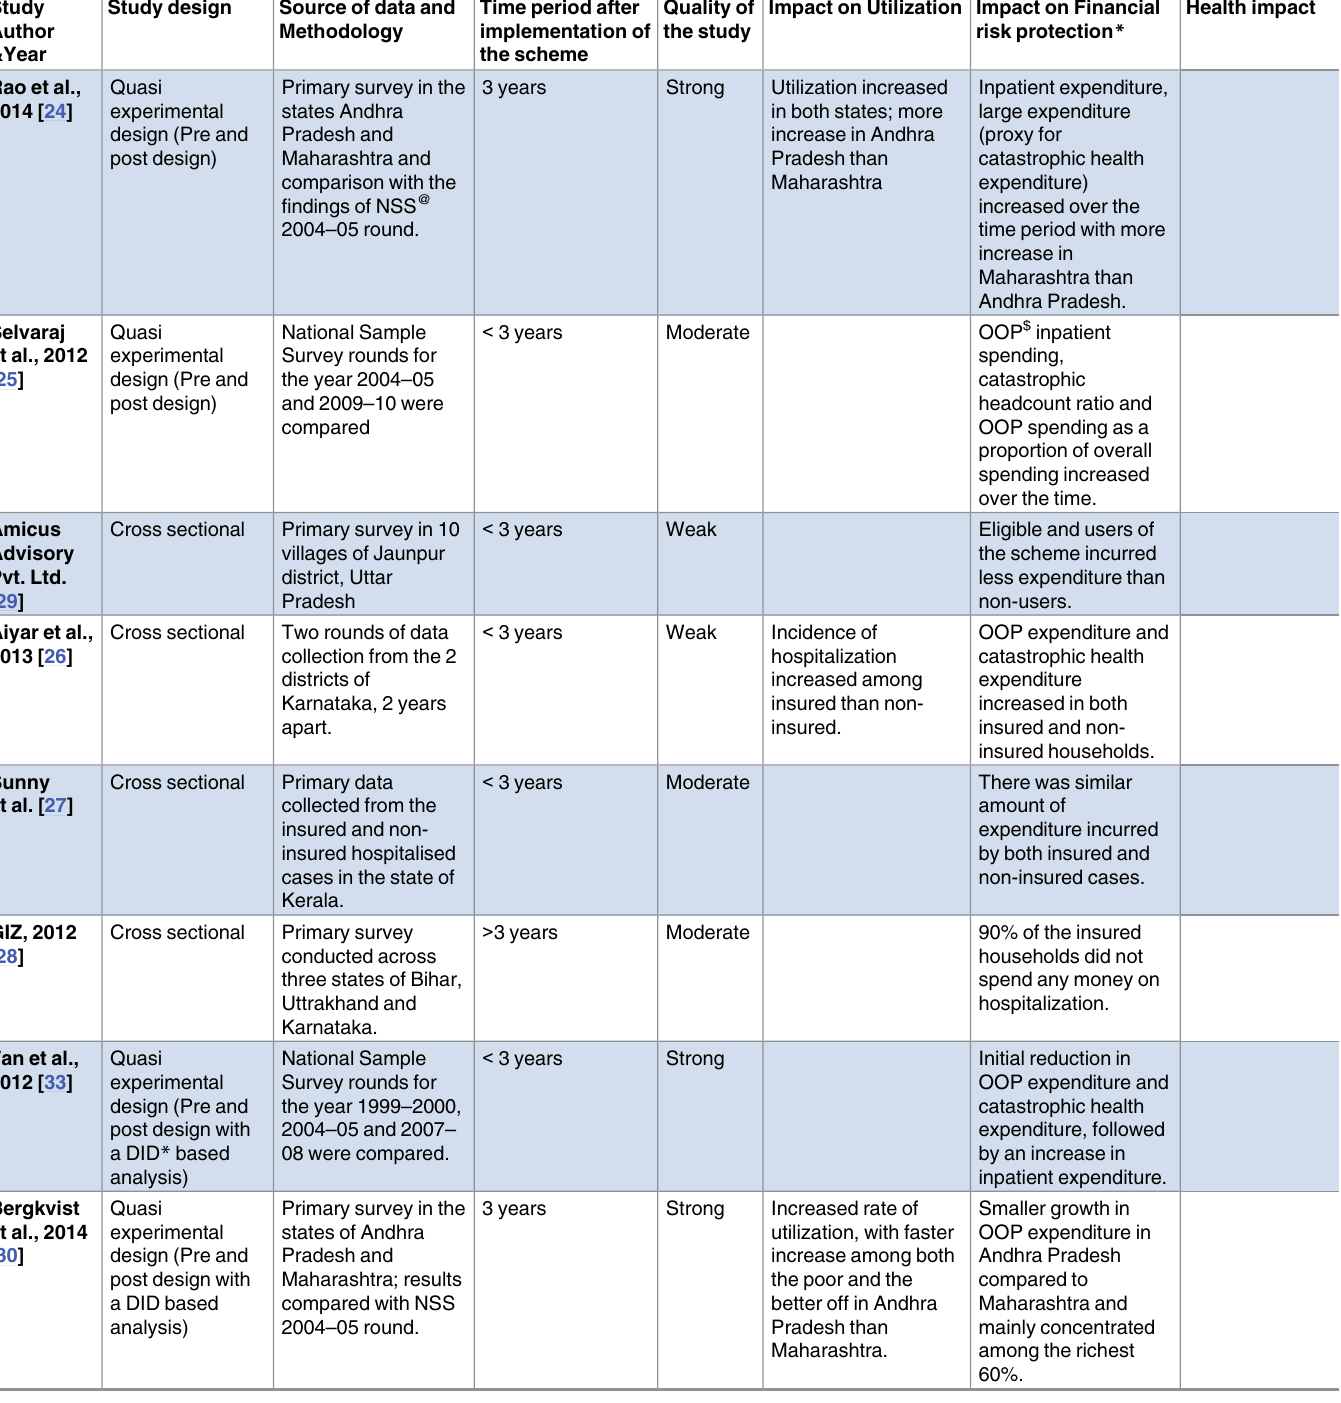
Table 2. Methodological characteristics and findings of the studies with a comparison